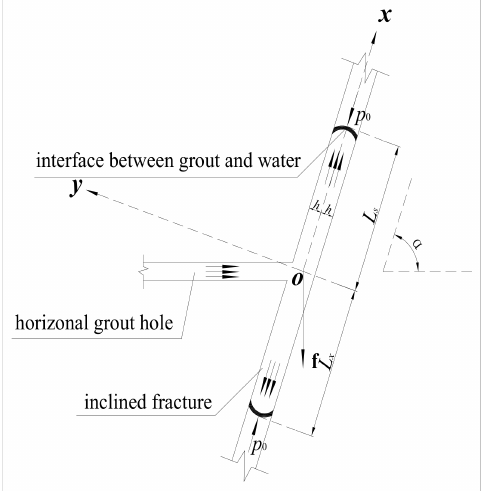
Figure 2. Grout force in a horizontal grouting hole inclined parallel